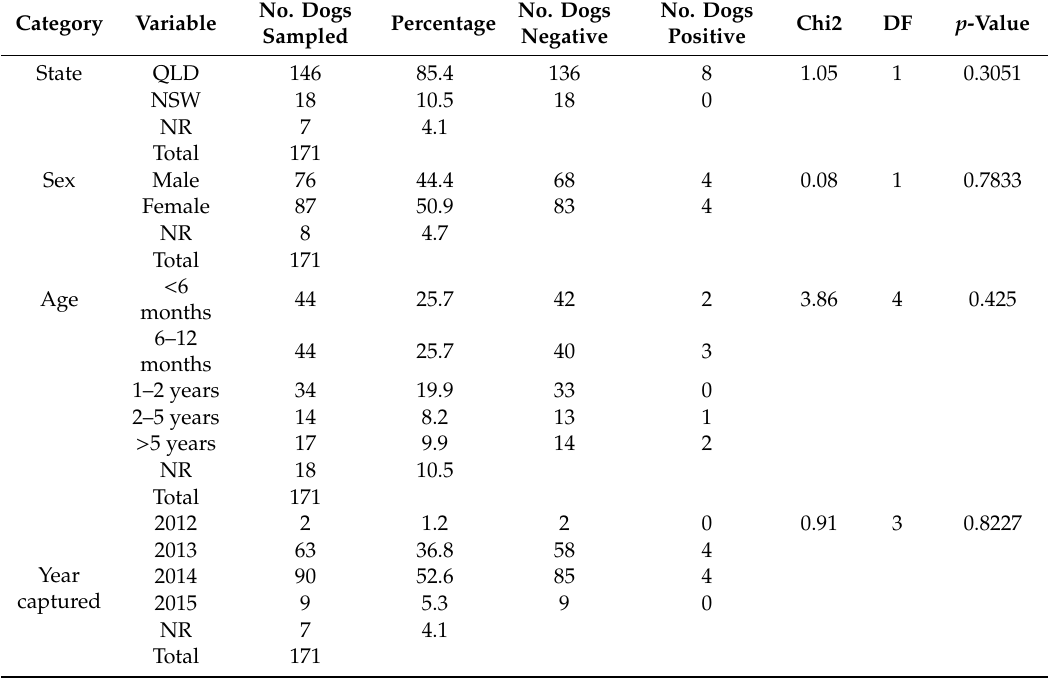
Table 2. Australian wild-dog cadavers made available for PCR testing for canine parvovirus DNA, and test results, categorized by state of origin, sex, age and year trapped.